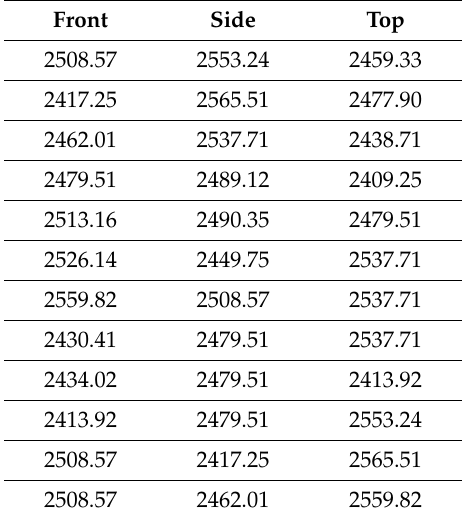
Table 11. DOE setup for E as a function of build orientation.